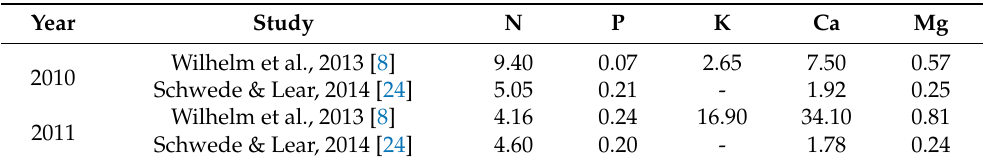
Table A2. Average deposition values in kg ha − 1 for the years of 2010–2011 on the harvest intensity study site in northern Wisconsin. The values reported in the Wilhelm study generally overestimate the values in comparison to Schwede & Lear (2014)